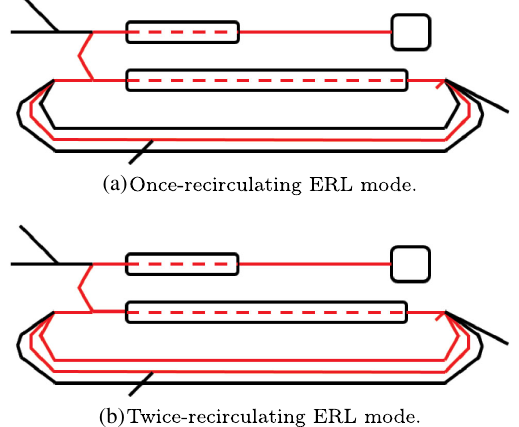
FIG. 3. The S-DALINAC lattice is capable of a once- or twice- recirculating ERL operation. The 180° phase shift is performed in the second recirculation beamline.